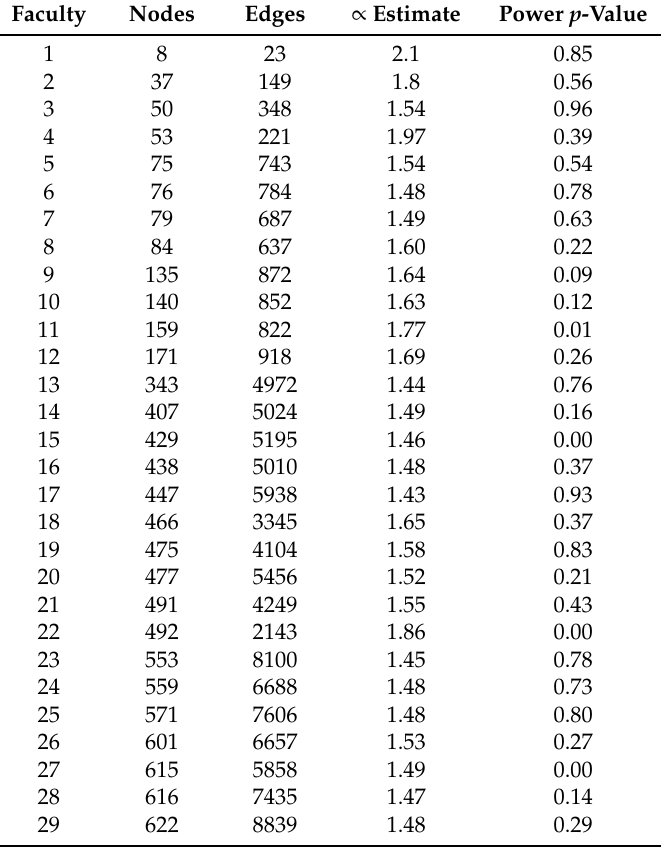
Table 2. Faculty scale free